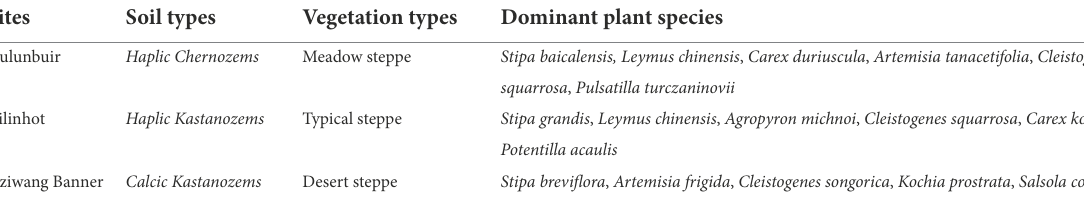
TABLE 1 Descriptions of soil classifications, vegetation types, and dominant plant species for each site in this study. Sites Soil